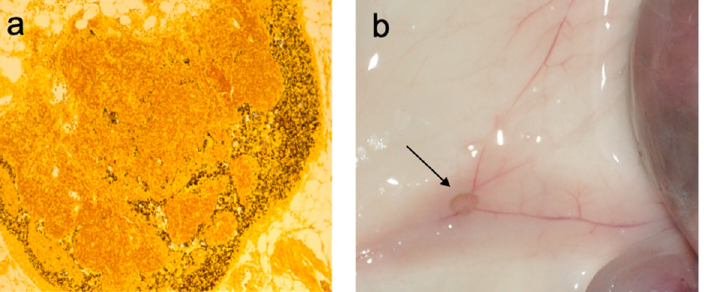
Figure 3. Melanin deposits within lymph nodes in vivo in Balb/c mice mice, 48 h after subcutaneous injection of 100 µ g of synthetic L-3,4-dihydroxyphenylalanine (L-DOPA) melanin. ( a ) Fontana–Masson staining of a draining lymph node, showing melanin-laden macrophages in the sinuses and in the paracortical area; ( b ) macroscopic aspect of the draining inguinal lymph nodes (arrow) (data from our lab).